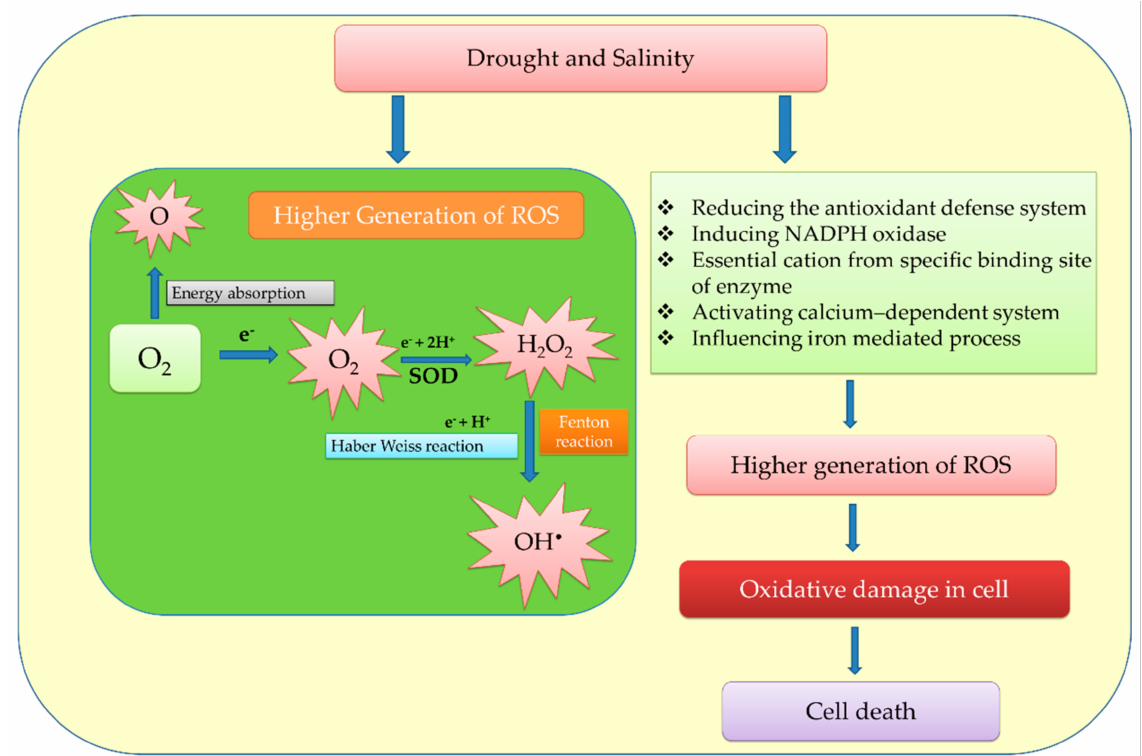
Figure 1. Drought and salinity-induced ROS generation in plants. Drought and salinity stress generates ROS via Fenton and Haber-Weiss reactions. ROS production by abiotic stresses modulates the enzymes (such as inducing NADPH oxidase and decreasing the antioxidant glutathione pool), activating calcium-dependent systems and altering iron-mediated processes. This led to a higher damage of ROS, thereby causing oxidative stress and damaging the cellular